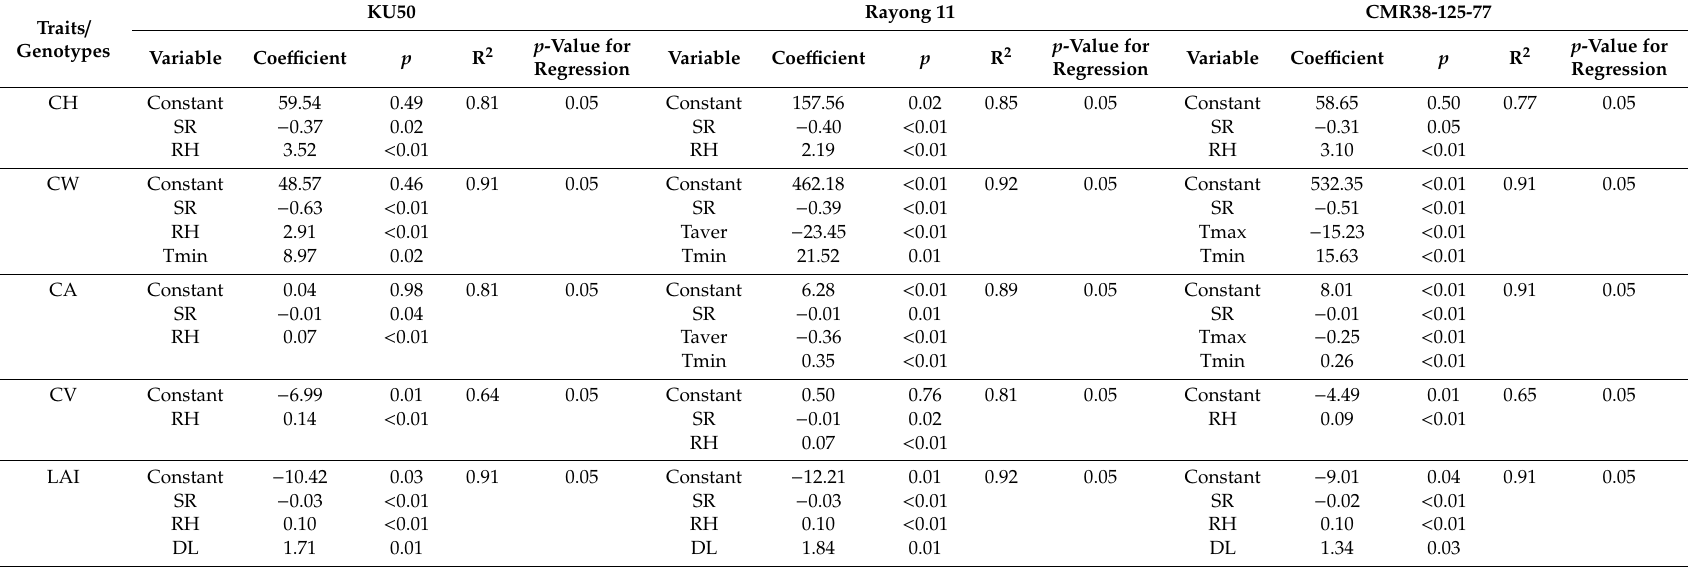
Table 3. Stepwise regression analysis for canopy traits and climatic factors for three cassava genotypes planted in May